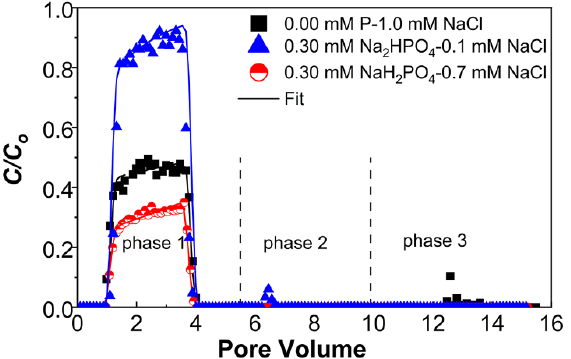
Figure 4. Breakthrough curves of PNPs under IS = 1 with different combinations of phosphate and NaCl at pH = 7. The release of PNPs was initiated by eluting with ultrapure water under pH 7 (phase 2) and pH 10 (phase 3), respectively.